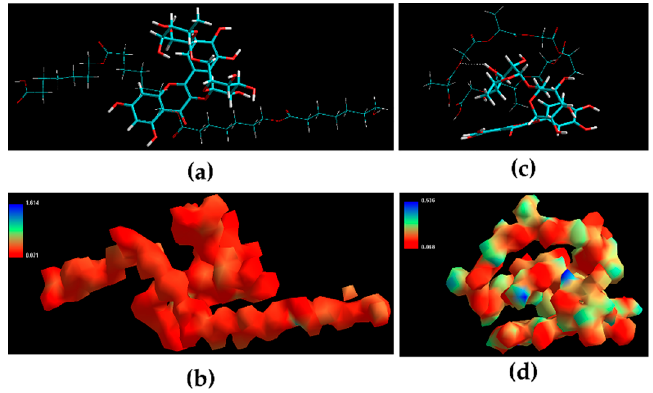
Figure 8. Representation of ( a , c ) geometrical preferences ( b , d ) electrostatic molecular graph after molecular mechanics simulations in vacuum ( a , b ) PCL-Rutin ( c , d ) PLGA-Rutin [Colour code for elements: C = cyan; H = white; O = red; N = blue]. Rutin: tube rendering; PCL: stick rendering; PLGA: stick rendering.